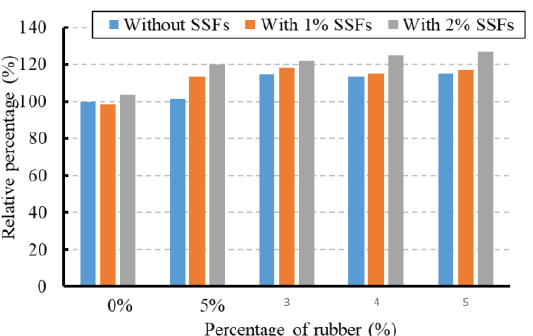
Figure 24. Compressive toughness of concrete with CR and SSFs normalized to the reference mix.